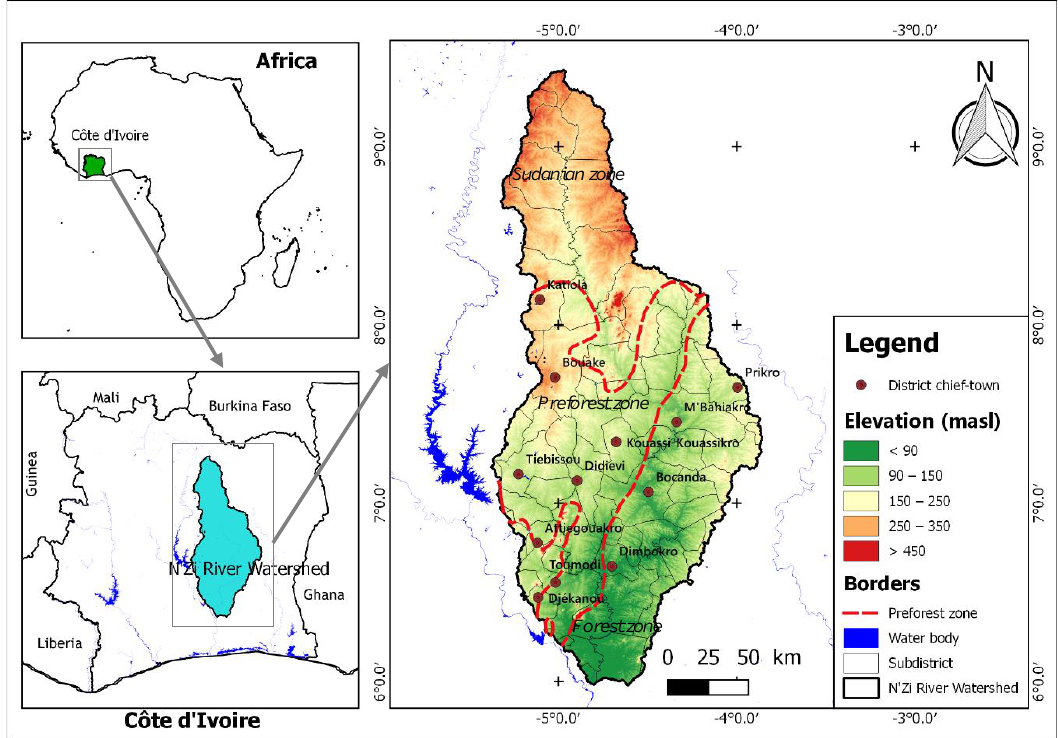
Figure 1. Map of N’Zi River Watershed